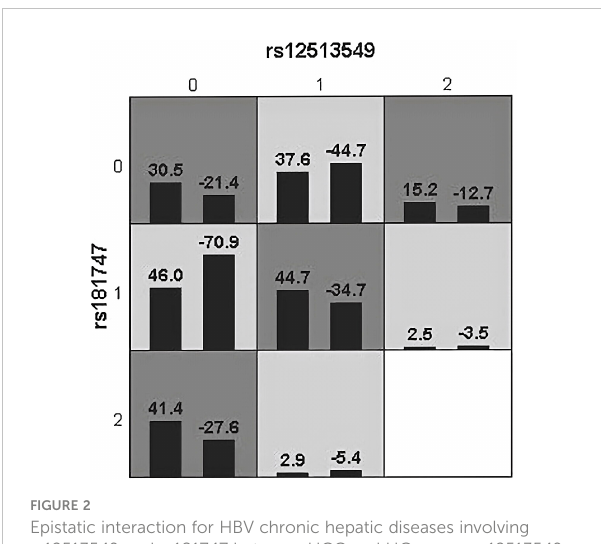
FIGURE 2 Epistatic interaction for HBV chronic hepatic diseases involving rs12513549 and rs181747 between HCC and HC group. rs12513549 (0, 1, 2)=rs12513549(GG, GT, TT);rs181747(0, 1, 2)=rs181747(TT, TC, CC). The scores of HCC group (left black bar in boxes) and HC (right black bar in boxes) are shown for each genotype combination.